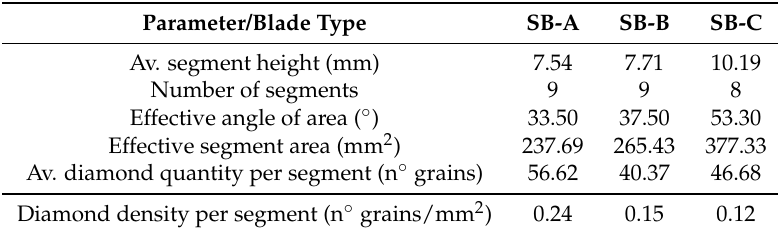
Table 2. Estimated density of diamonds per effective segment area of each